Question: Summarize what this figure shows in one sentence.
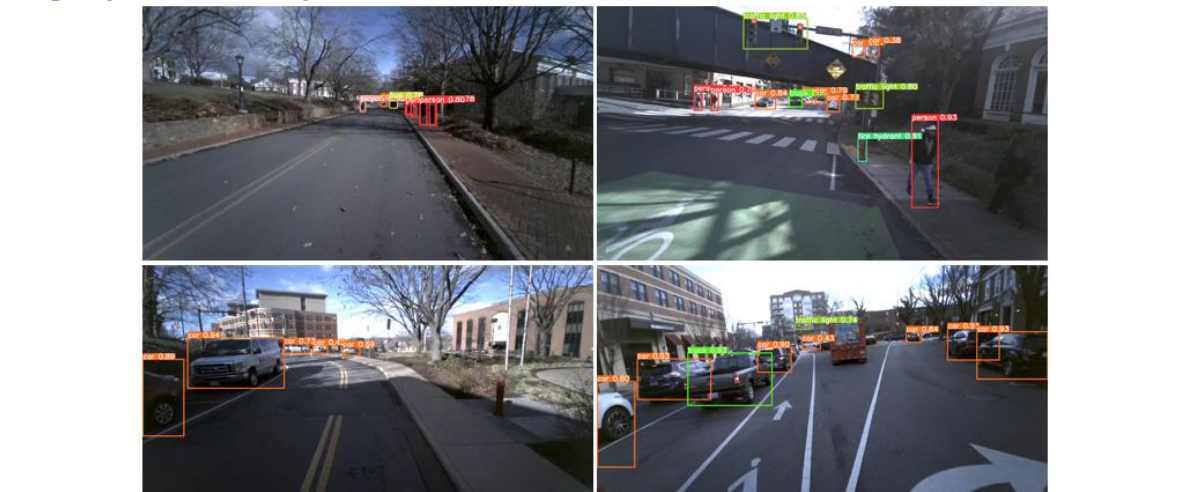
Answer: Examples of traffic scene images with predicted bounding boxes.    These outcomes collectively highlight the effectiveness of the chosen YOLO object  detectors in accurately identifying multiple classes of traffic objects in the context of e-scooter use.  The ability of these detectors to maintain high accuracy in complex urban settings underscores